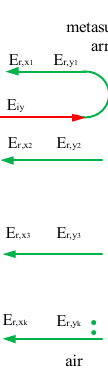
Figure 5. Schematic diagram of multiple reflections in the Fabry–Pérot-like reflective polarization converter.